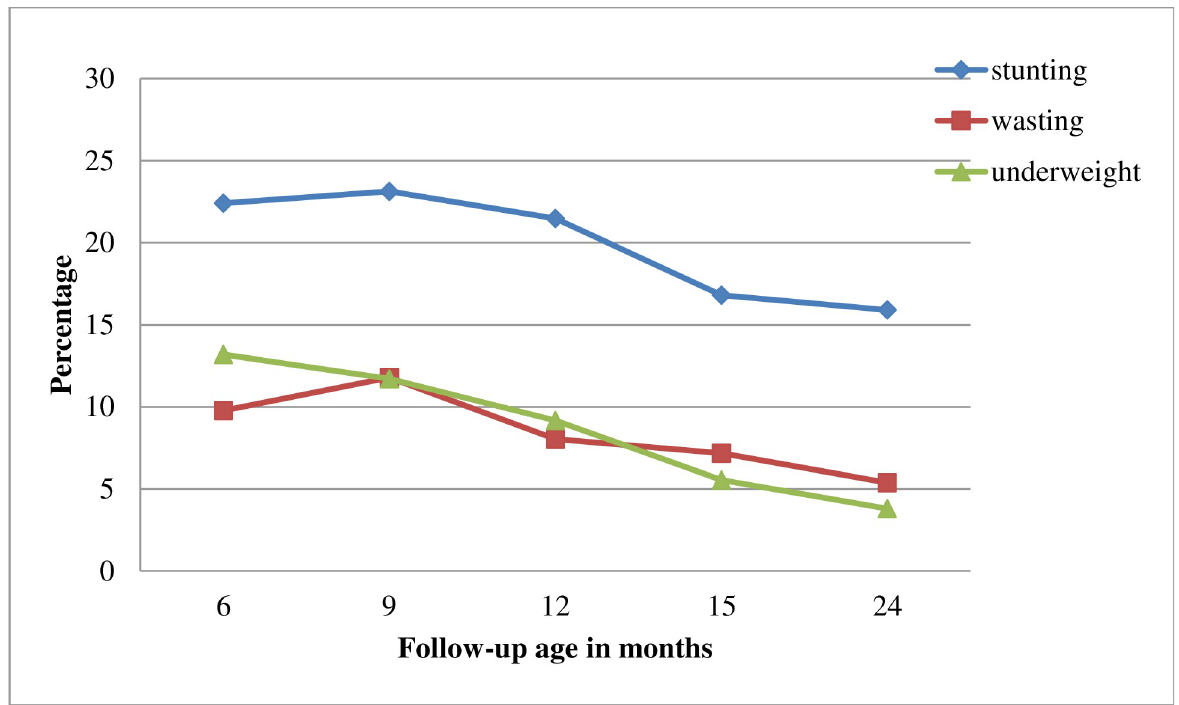
Fig 2. Proportion of children with undernutrition across follow up months.